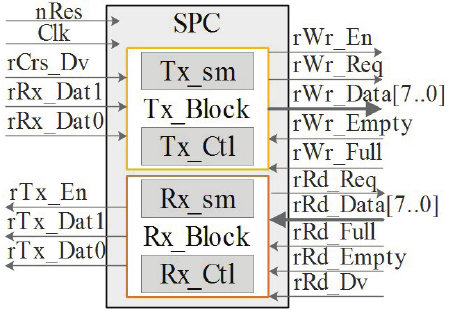
Fig. 4. SPC Logic and Signal Definition. Table 1. I/O Definition of